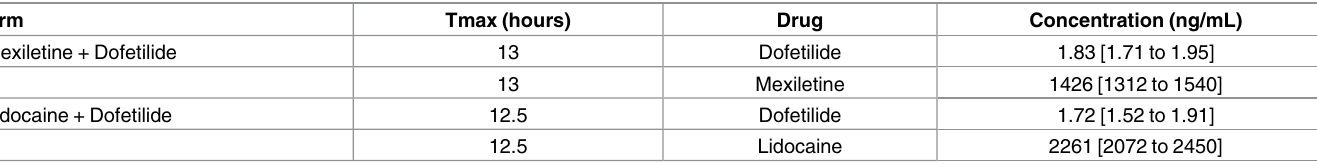
Table 2. Cmax time-points (Tmax) and plasma drug concentrations of mexiletine and lidocaine when given in combination with dofetilide.